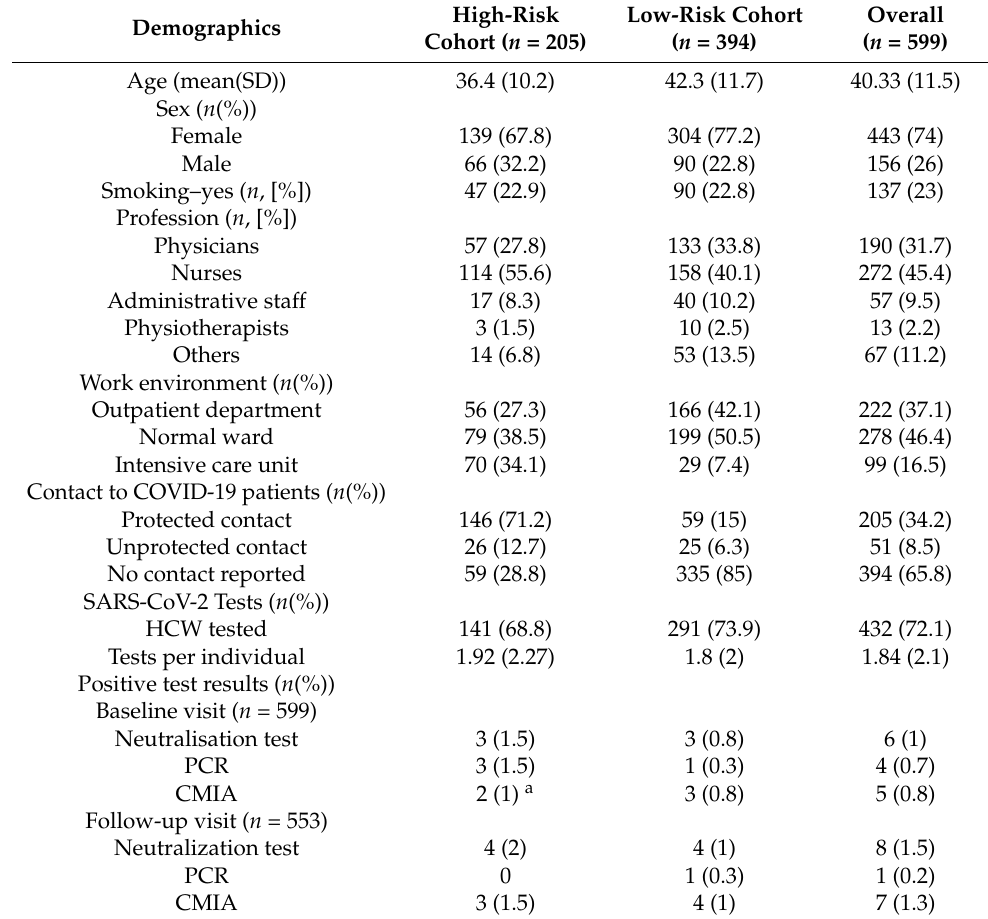
Table 1. The demographic characteristic of our cohort. SD, standard deviation; COVID-19, Coron- avirus Disease 19; HCWs, Health Care Workers; SARS-CoV-2, severe acute respiratory syndrome coronavirus; PCR, polymerase chain reaction; CMIA, chemiluminescent microparticle immunoassay; a one HCW tested positive by PCR did not appear positive by CMIA but in neutralization